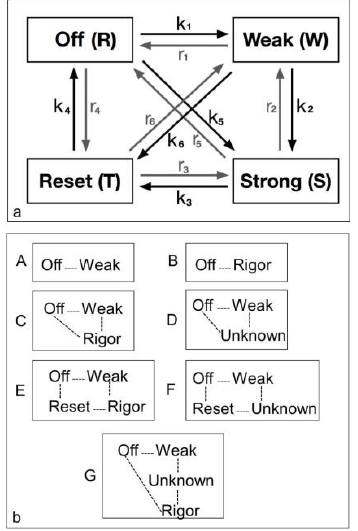
Figure 2. Possible models for the crossbridge cycle including 4 or fewer structural states and the transitions between them. For convenience the states have been given names. ( a ) A general model for the crossbridge cycle including four possible states and transitions between them. However, they can be considered in different ways as in ( b ). ( b )Various kinds of model (A to G) have been considered as described in the text. These include two 2-state models (A, B), two 3-state models (C, D) and three 4-state models (E, F, G).